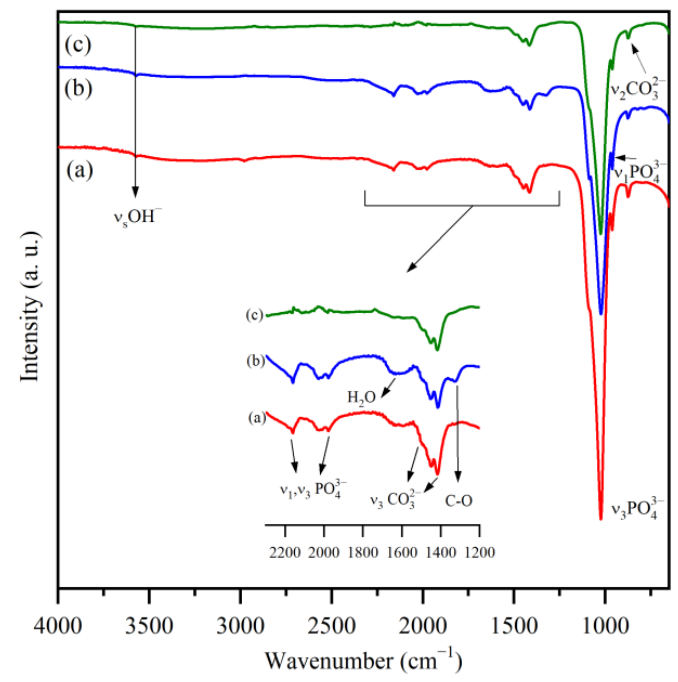
Figure 4. FTIR spectrum of the HAp (a) , HAp/OMWCNT (b) , and HAp/MWCNT (c) samples.